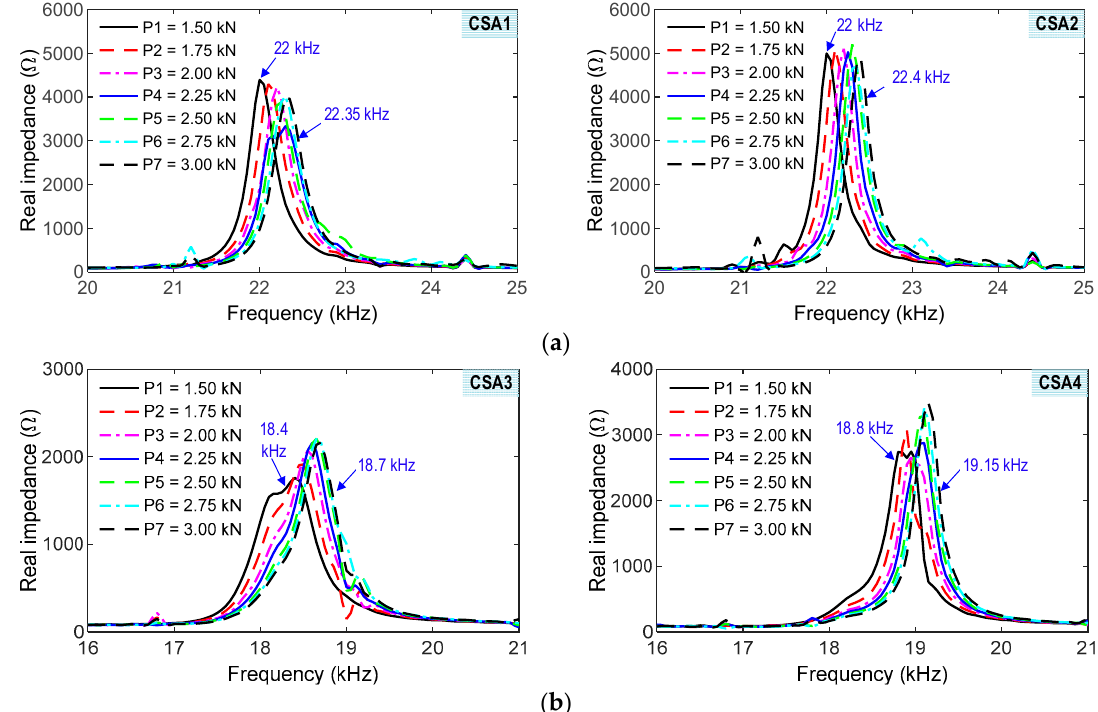
Figure 15. Experimental impedance signals of CSAs under compression. ( a ) z-directional loading. ( b ) x-directional loading.